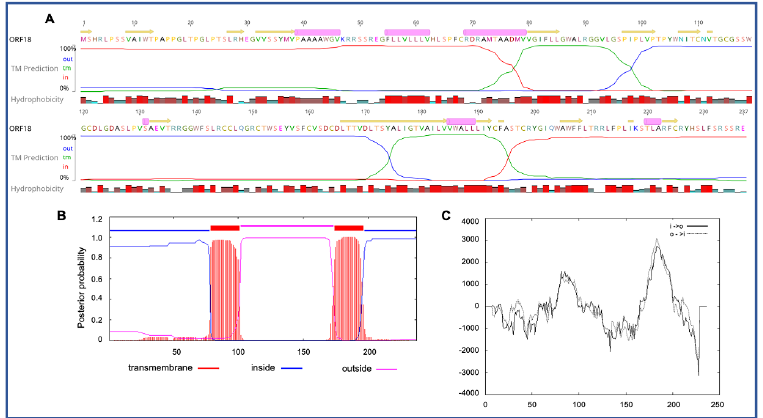
Figure 3. Predicted structure of the unique PaAdV1-ORF18. ( A ) prediction of transmembrane helices (TMHs) in unique PaAdV1-ORF18 gene, using EMBOSS 6.5.7 tool in Geneious (version 10.2.2) ( A ), TMHMM ( B ), and TMpred ( C ). All the programs consistently predicted two TMHs. (A) TMHs detected by EMBOSS also showed the presence of alpha-helices within TMHs predicted region that has been dominated by highly hydrophobic residue (red colour). ( B , C ) The x -axis represents the position of residue, whereas the y -axis represents the posterior probability ( B ) and scores (above 500 were considered significant) ( C ) for the predicted TMHs. ( C ) Solid and dashed black lines indicate protein orientation as inside to outside, and outside to inside, respectively.